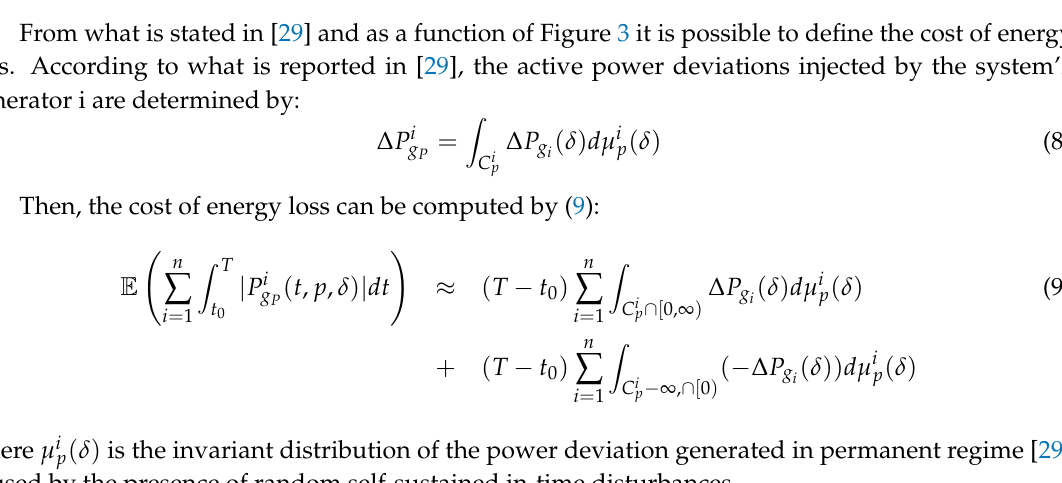
Figure 3. Active power deviations and their respective ranges in permanent